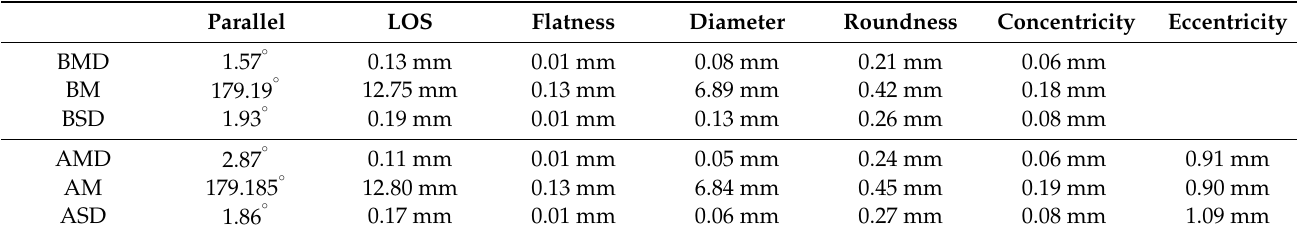
Table 5. Circle abnormal nut